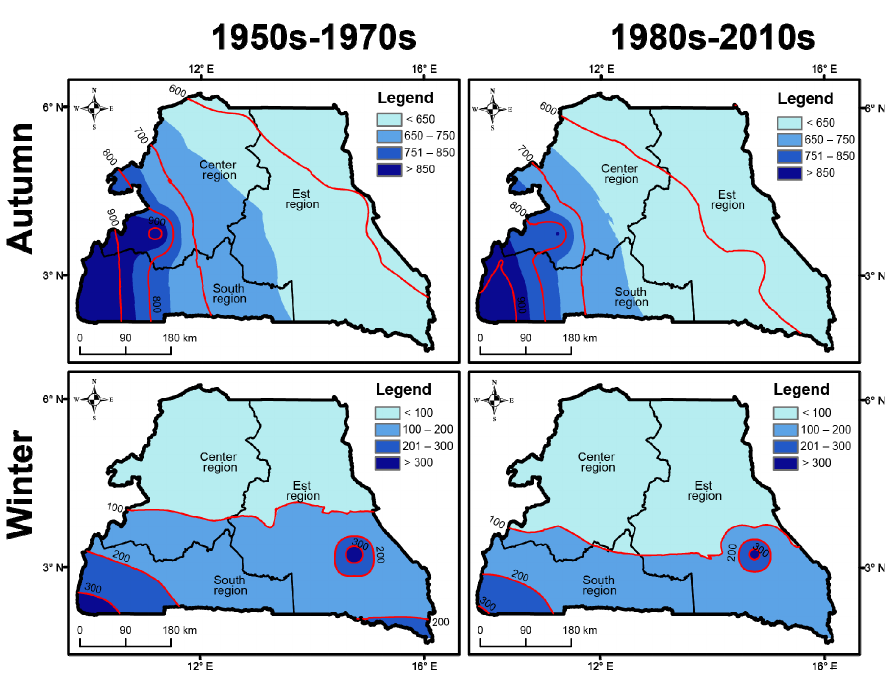
Figure 10. Spatial distribution of mean rainfall for the southern regions of the country (Center, East, and South) at seasonal and annual time scales, between the decades 1950–1970 and 1980–2010.